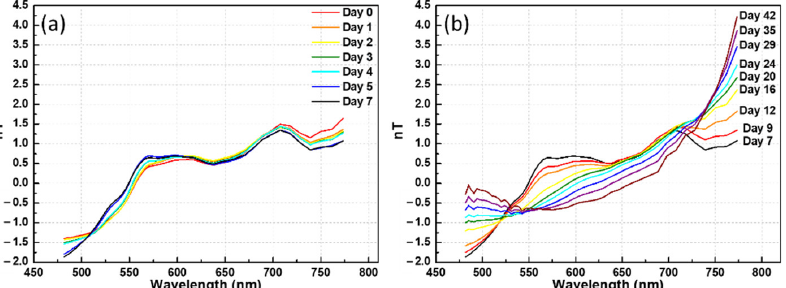
Figure 7. Normalized transmittance, nT, obtained by the standard normal variate: ( a ) 0–7 days and ( b ) 7–42 days.